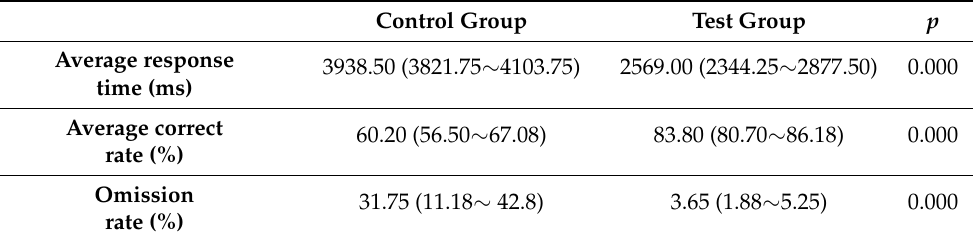
Table 5. Comparison table of the results of the